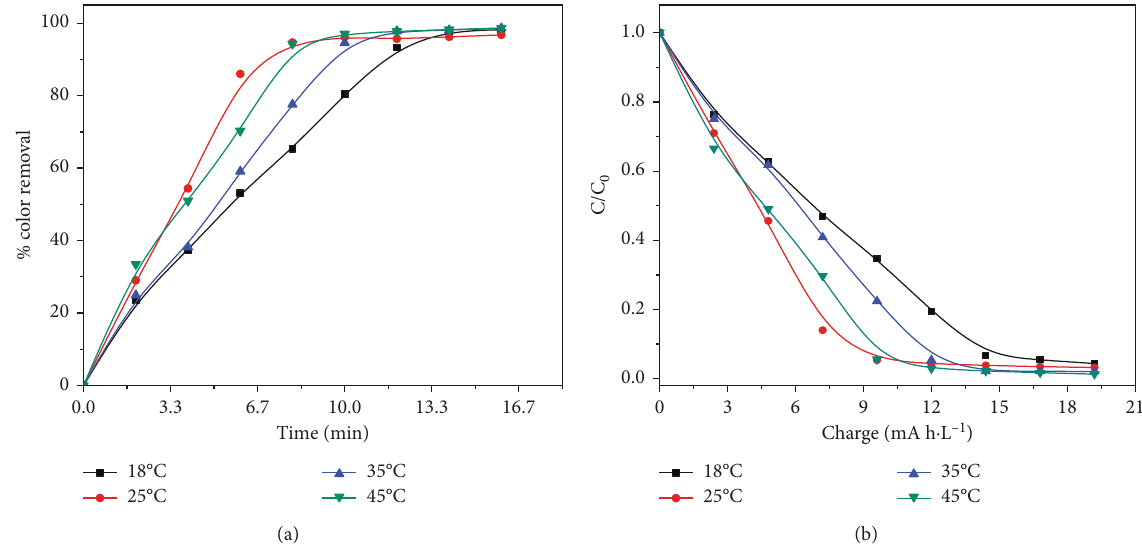
Figure 6: Temperature influence on the decay of Rh-B concentration during the electrolysis treatment. Conditions: [NaCl], 0.07 mol · L − 1 ; [Rh-B], 80mg · L − 1 ; current density, 3.9mA · cm − 2 ; flow rate, 30L · h − 1